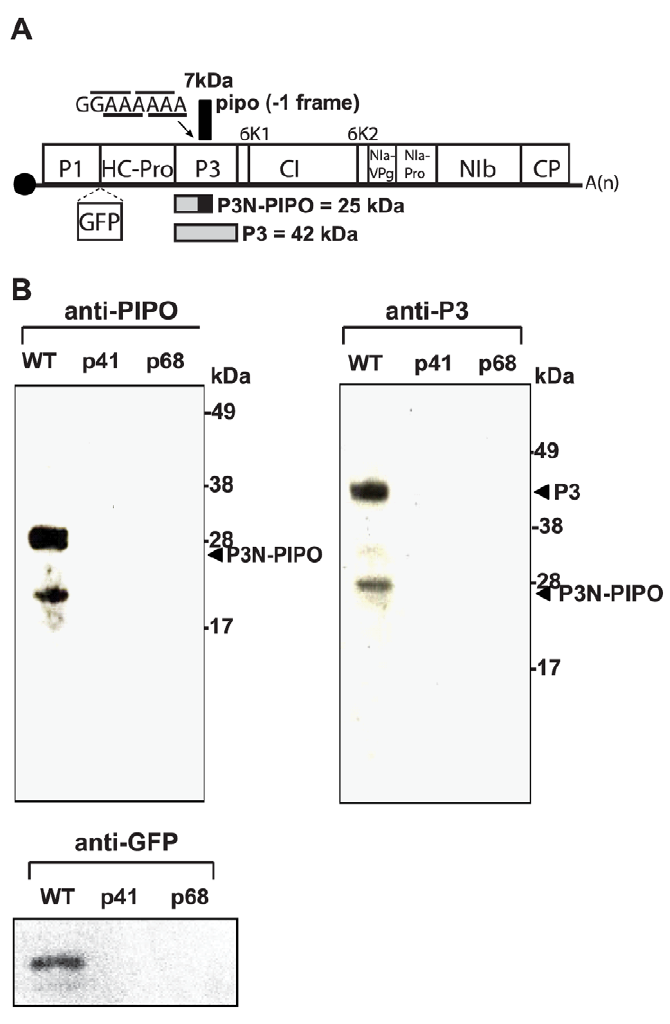
Figure 1. Genome map of TuMV-GFP and expression of P3N-PIPO inplanta . (A) Genome map of TuMV-GFP. Mature proteins processed from the proteolytic cleavage of the large polyprotein are indicated in boxes. pipo ORF is indicated above the polyprotein ORF with putative frameshift sequence indicated and bars showing codons in the polyprotein ORF (below) and pipo ORF (above). Sizes of P3N-PIPO and P3 proteins are indicated below the regions that code for them. P3-derived portion is shaded gray; PIPO-derived portion is in black. Position of inserted GFP coding insertion is indicated by dashed lines. Solid circle indicates VPg at 5 9 end; (A)n indicates poly(A) tail. (B) Immunodetection of P3N-PIPO and P3 in TuMV-GFP- infected Arabidopsis . Total protein was extracted from the infected leaves at 14 days post inoculation (dpi), separated in either 4–12% NuPAGE Bis-Tris gel (Life Technologies) (for P3-N-PIPO and P3 detections) or in 4–12% Novex Tris-glycine gel (for GFP detection), blotted onto PVDF membrane and probed with anti-PIPO, anti-P3 or anti-GFP antibody and detected by ECL-plus Western reagents. Positions of protein mobility markers in kilodaltons (kDa) are indicated at right. Lanes indicate total protein from plants inoculated with wild-type (WT) TuMV-GFP, or pipo knockout mutants of TuMV- GFP (p41 and p68). These mutants differ from WT TuMV-GFP by single point mutations that introduce stop codons into the pipo ORF: CGA R UGA and GGA R UGA at bases 3103 and 3130 in mutants p41 and p68, respectively ( pipo -frame codons shown). These mutations do not alter the amino acid sequence of the overlapping P3 region of the polyprotein. Note that putative P3N-PIPO migrates more slowly ( , 28 kDa) than its predicted molecular weight ( , 25 kDa).